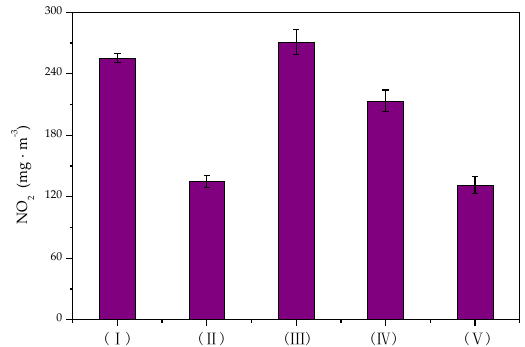
Figure 9. Concentration of NO 2 formed in different reactors.